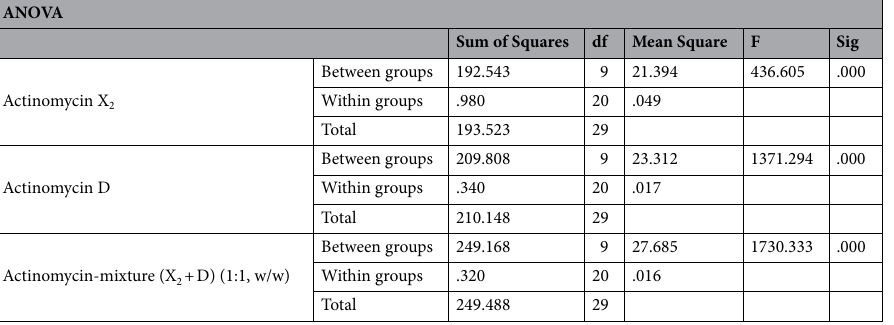
Table 3. One-way ANOVA for primary antimicrobial activity of isolated actinomycins X 2 , D, and X 2 + D.